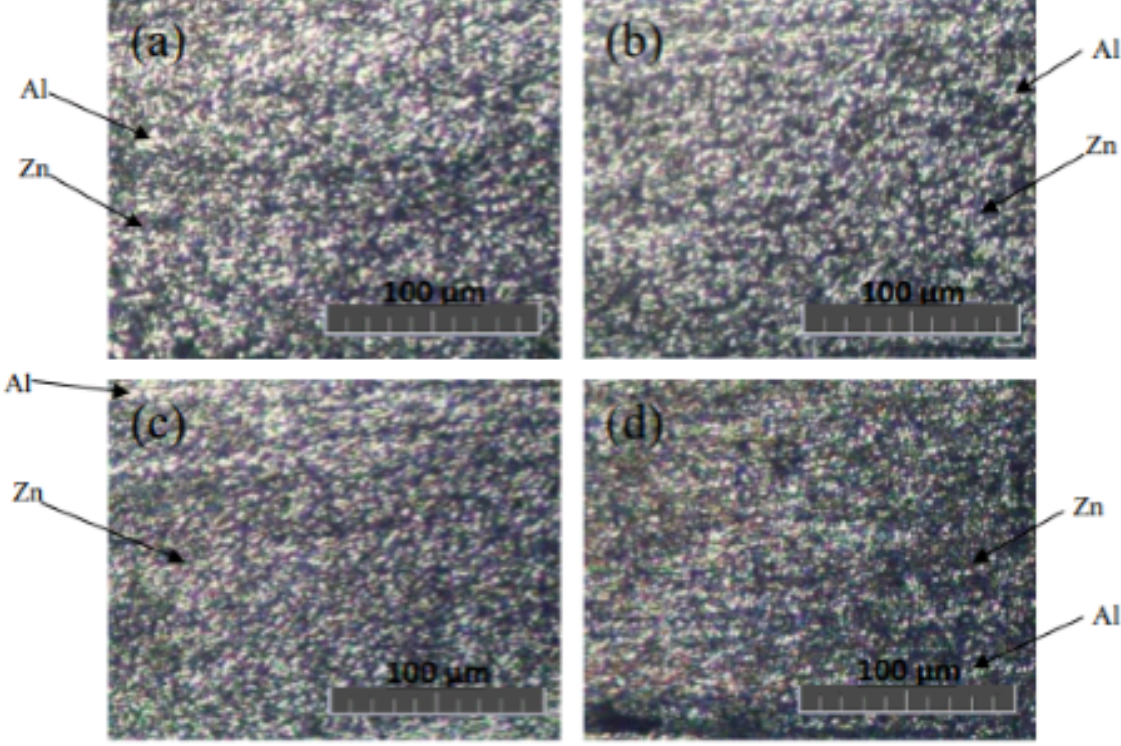
Figure 4: Microstructure of friction stir-welded specimen under various Zn Particle volumes of (a) 22 mm 3 , (b) 45 mm 3 , (c) 67 mm 3 , and (d) 90 mm